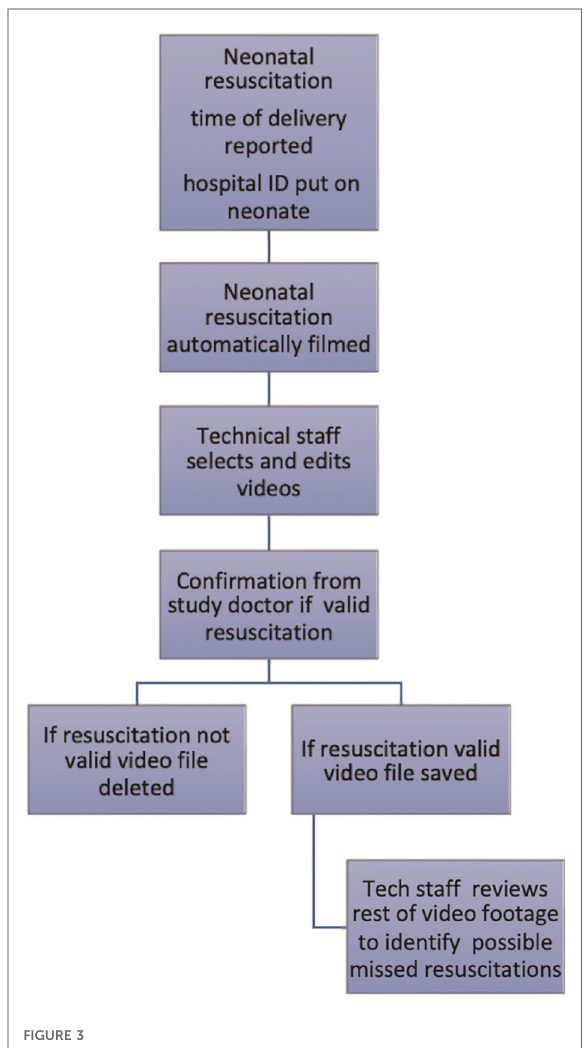
FIGURE 3 The process from delivery to veri fi ed video captured resuscitation, Uganda, and